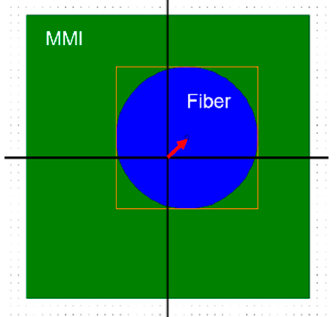
( b ) Figure 9. Near-field distribution of waveguide output for the 1 × 9 MMI splitter excited by a laser at 1550 nm: ( a ) Top-down 2D graphic interpretation of the intensity distribution; ( b ) 3D interpretation of the intensity distribution. The size of 1 × 9 MMI was outside the range of the maximum area measurable by NSOM, so one of the maxima is not present in the measured intensity distribution. Alt- hough one can see that the 1 × 9 MMI splitter fulfils its function even with the cropped image, the number of peaks and their separation is clearly visible. The observed maxima are separated by ~8.3 μ m and correspond with the simulation in Figure 5. Furthermore, the shape and intensity distribution reflect the simulated results. Both splitters show a bias towards one of the corners of the structure. This phenom- enon could be explained by the off-centre position of the input fibre in relation to the input waveguide, or by the shift of the input modal field in the input fibre itself due to the bend- ing of the fibre in the measurement setup. The effects of the input fibre position shift were verified by the simulations in the following section.